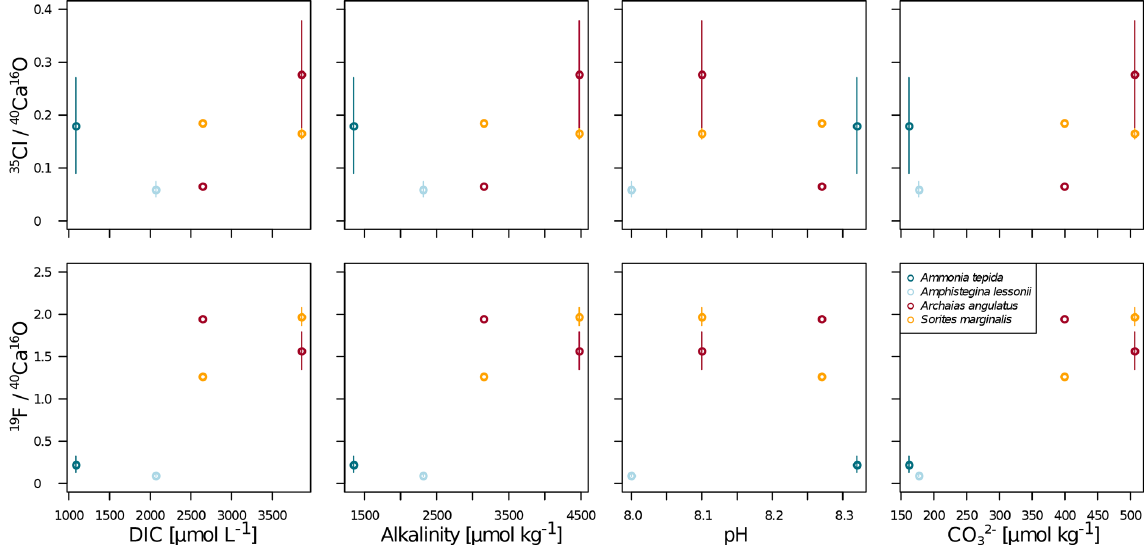
Figure 4. Cross plots of NanoSIMS 35 Cl / 40 Ca 16 O and 19 F / 40 Ca 16 O ion count ratios with carbonate system parameters of the culture media. The error bars depict 1 standard error of the mean NanoSIMS ion count ratios where more than one image was analysed per specimen. The calculation of correlations was not attempted due to the low number of replicate